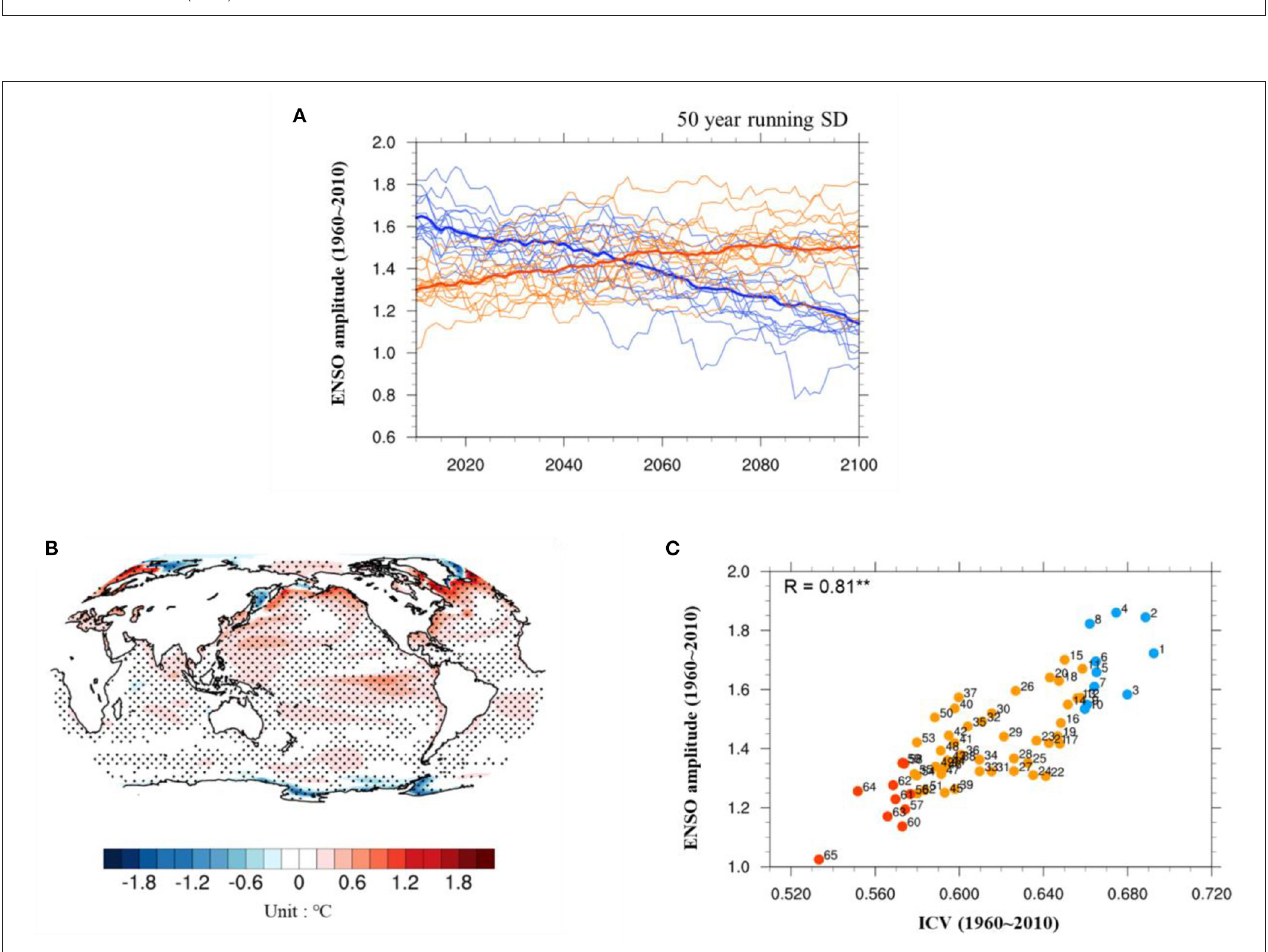
FIGURE 3 | (A) Time-varying ENSO amplitude simulated in 10-ensemble members from the Strong_ICV (blue) and Weak_ ICV (red) as well as their ensemble means (thick lines). (B) The difference of surface temperature standard deviation between Strong_ICV and Weak_ICV during the present climate (Strong_ICV minus Weak_ICV). The dotted area indicates the region where the difference is statistically significant at the 95% confidence. (C) Scatter plot of ICV vs. ENSO amplitude in the present climate (1960–2010). Blue (red) dots in (C) denotes Strong_ICV (Weak_ICV) group. Unit is ◦ C. Note that numbers in (C) denote the 65-ensemble members ranked by the intensity of ICV from the strongest to the weakest during the present climate (see Figure 2 ).